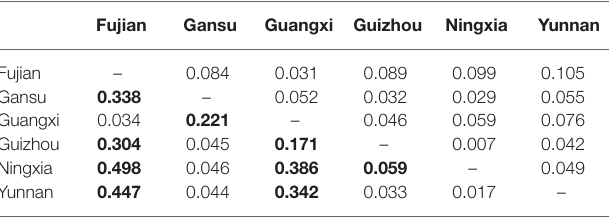
Bold font indicates that AVR4 F ST is greater than SSR F ST in the pair of P. infestans